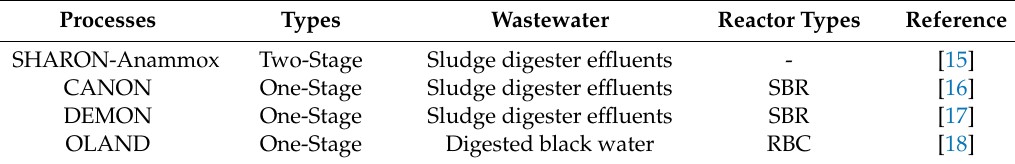
Figure 2. Previous studies about sequencing batch reactor (SBR) and moving bed biofilm reactor (MBBR) for the anammox process (Data source: Web of Science). Table 2. Types of anammox